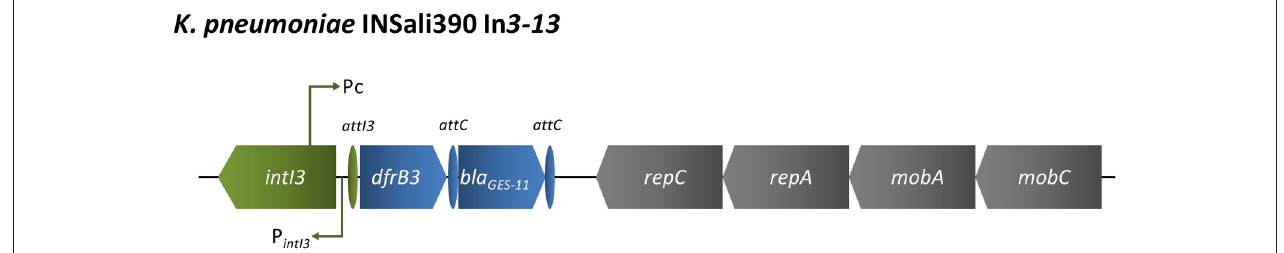
FIGURE 4 | Schematic representation of region enclosing In 3–13 detected in a K. pneumoniae recovered among the bacterial population analyzed in the present survey ( n = 1/333). Green, integron; blue, resistance genes, including gene cassettes; purple, transposons; gray, other